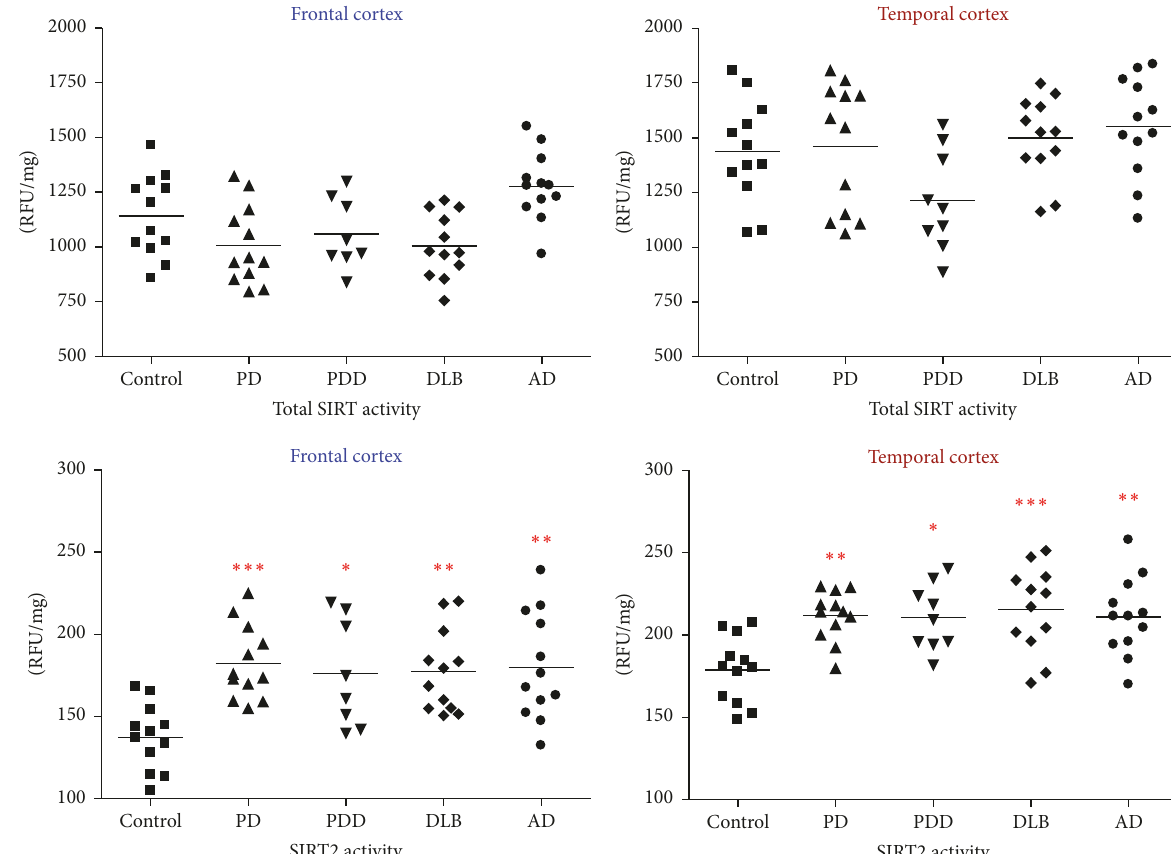
Figure 10: Total SIRT and SIRT2 activities in the frontal and temporal cortex in PD, PDD, DLB, AD, and controls. Total SIRT and SIRT2 activities were measured through a fluorometric enzymatic activity assay in the frontal and temporal cortices of PD, PDD, DLB, and AD patients and were compared to cohort-control group. ∗∗∗ 𝑝 < 0.001 , ∗∗ 𝑝 < 0.01 , and ∗ 𝑝 < 0.05 when compared to control, one-way ANOVA (Bonferroni